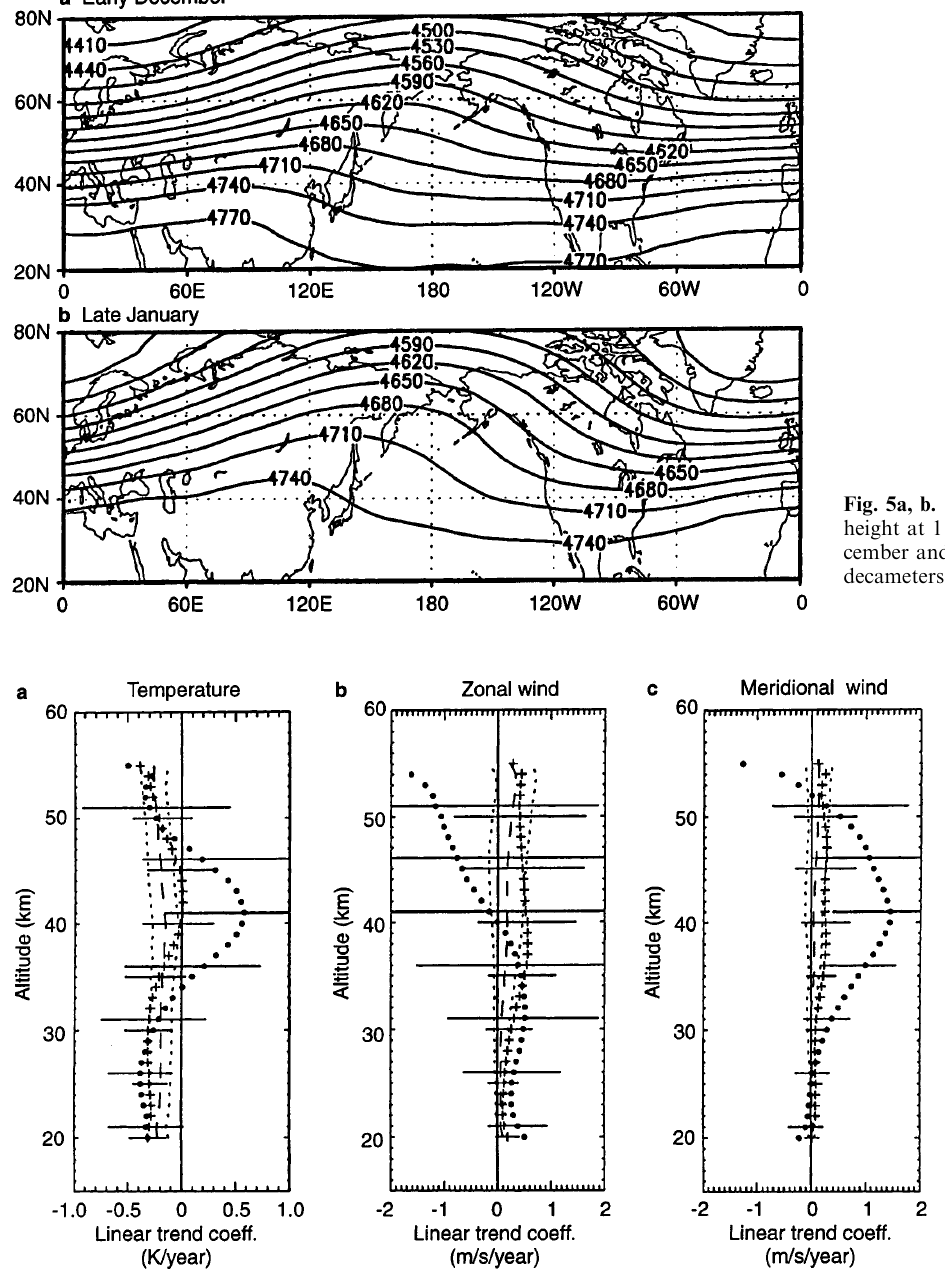
Fig. 6a–c. As Fig. 2 except for trend. In this case, circles are associated with December